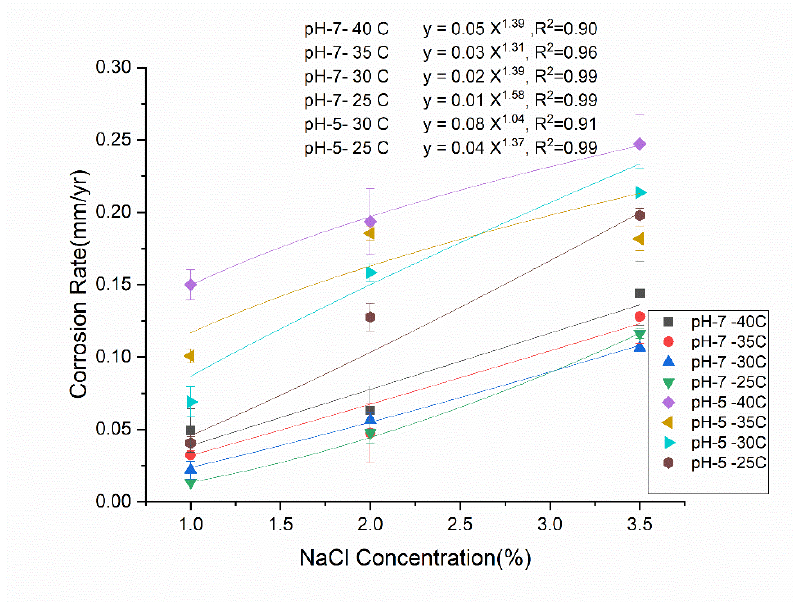
Figure 12. Corrosion rates for flow insensitive region are fitted with varying NaCl Concentration.